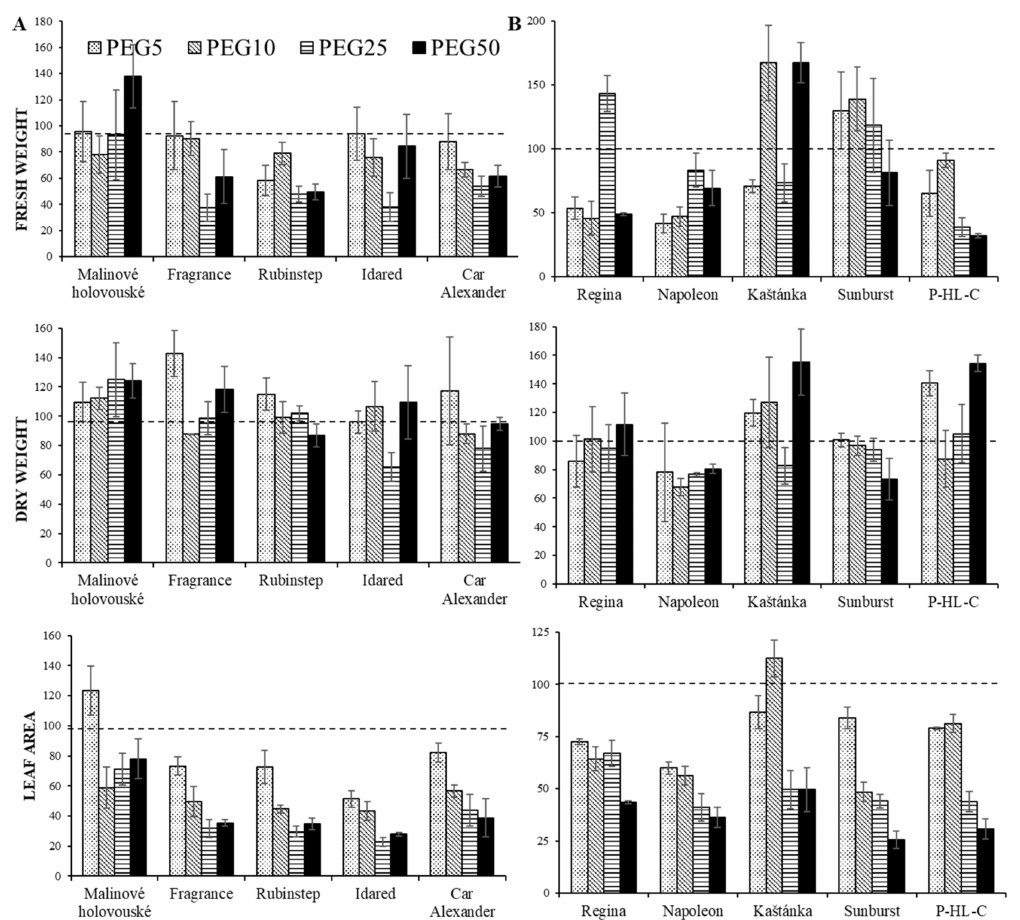
Figure 2. E ff ect of di ff erent concentration of PEG-6000 on content of fresh weight (g), dry weight (g), and leaf area (mm 2 ) in in vitro culture of apple ( A ) and cherry ( B ) cultivars. All bar values were recalculated relative to the compound content in untreated samples taken as 100% (dashed line). Error bars represent means ± SDs (n =